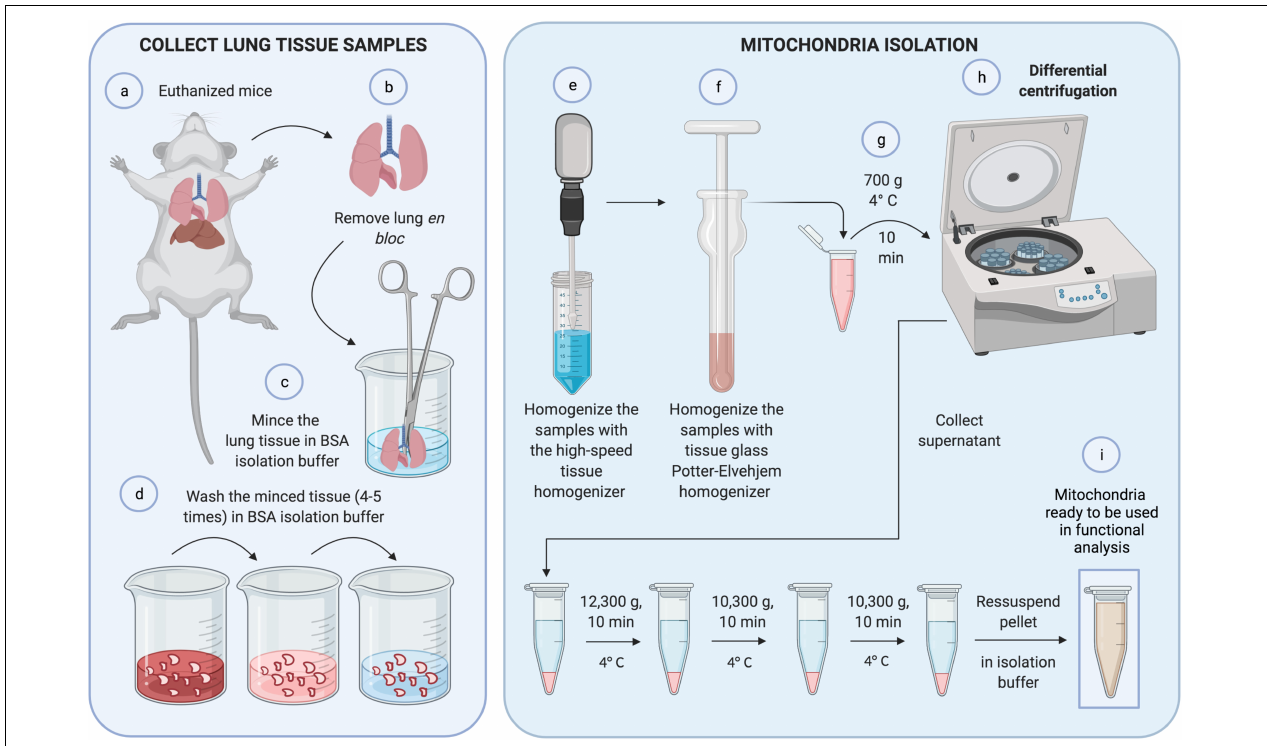
FIGURE 1 | Mitochondrial isolation. First, (a,b) lungs were removed in bloc from euthanized mice. (c) Lung tissue was minced with scissors and (d) washed with BSA isolation buffer four to five times to eliminate blood. (e) The sample was homogenized with a high-speed tissue homogenizer and, again, with tissue glass Potter-Elvehjem homogenizer carefully, to achieve cell disruption without compromising mitochondrial integrity (f) . (g) The homogenate was centrifuged at 700 g for 10 min at 4 ◦ C. (h) The pellet was discarded, and the supernatant was collected and submitted to differential centrifugation. Finally, (i) the resultant pellet containing mitochondria was ready to be used in functional